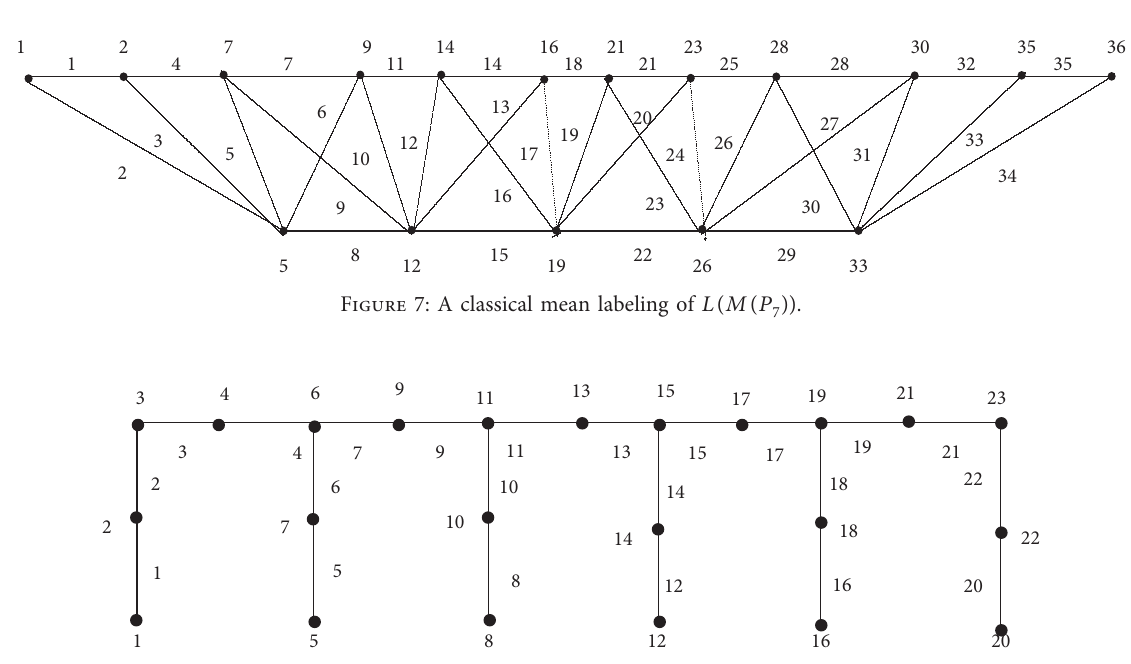
) . Therefore, a classical mean labeling of S ( P K 6 ° 1